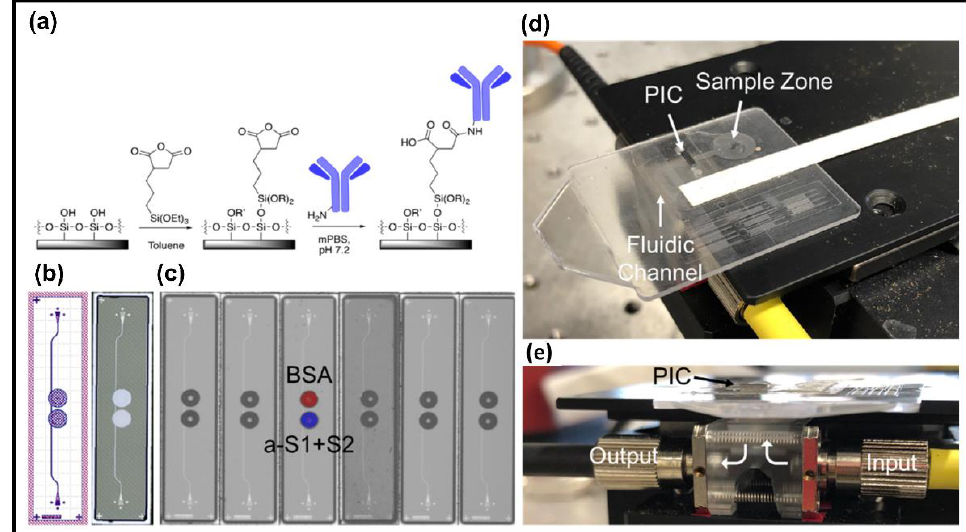
Figure 5. Disposable photonic assay platform. ( a ) Functionalization schematic. ( b ) GDS (graphic design system) and laser confocal image of the 1 × 4 mm photonic chips. ( c ) Image of antibody and antigen solutions spotted on chips with a Scienion SX microarrayer. ( d ) Image of the full microfluidic and photonic chip assembly. ( e ) Side view of the custom optical hub. Infrared light from a tunable laser is coupled vertically into and out of the photonic chip from below. Reprinted with permission from [73], copyright 2021, MDPI.